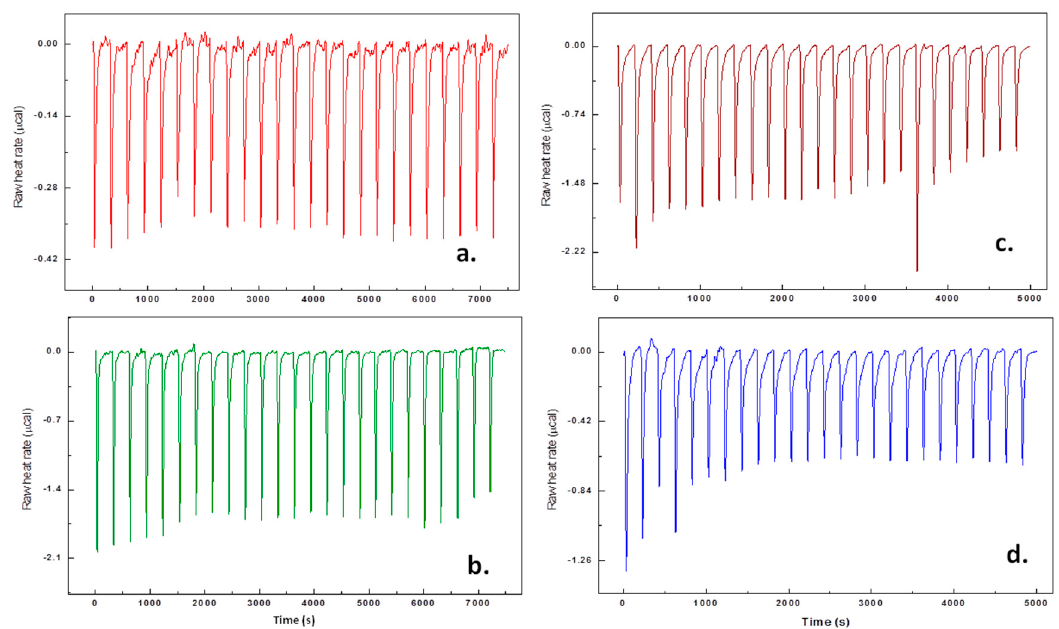
Figure 8. ITC data recorded for the interaction of L-His with different materials. ITC response for the blank titration ( a ); the raw data for the titration of 4 mg / mL graphite ( b ); 1 mg / mL GO ( c ); and 4 mg / mL TRGO ( d ) with L-His.